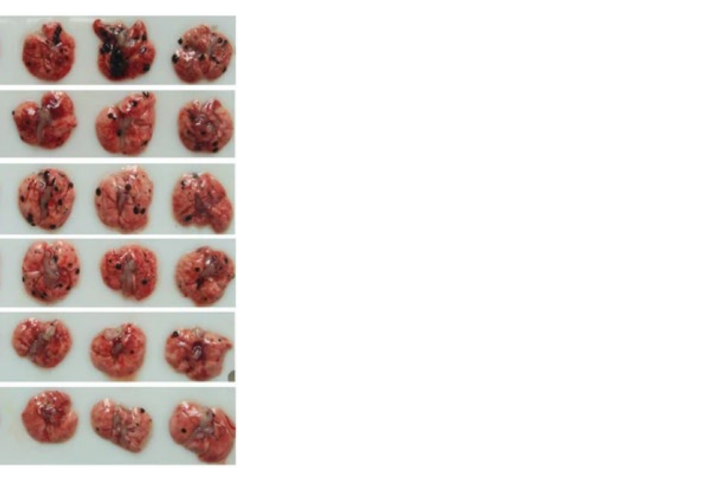
Figure 4. The effect of different complexes in killing cancer cells in mice lungs. Adapted from [85]. Springer Nature 2018.